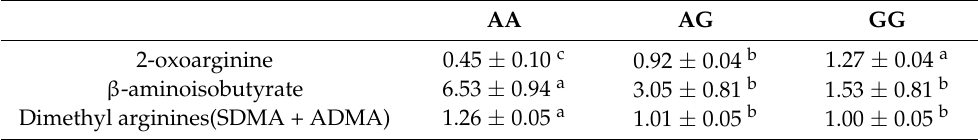
Table 2. Mean relative normalized concentrations of selected serum metabolites in cats with different alanine-glyoxylate aminotransferase 2 (AGXT2) single nucleotide polymorphisms (SNPs) from a genome-wide association study (GWAS) of 445 cats in the colony at Hill’s Pet Nutrition, Inc. AA AG GG 2-oxoarginine